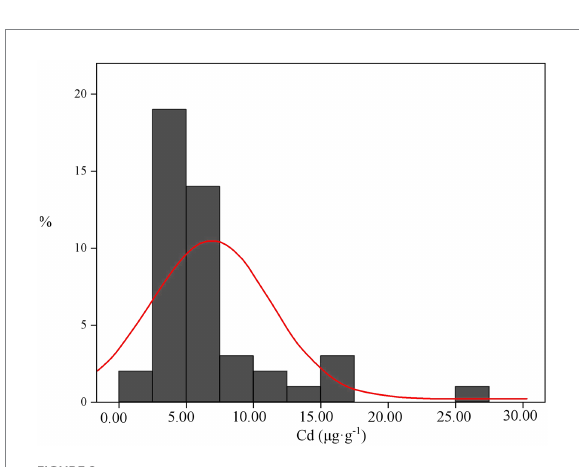
FIGURE 2 Histogram of soil Cd content in the study area.